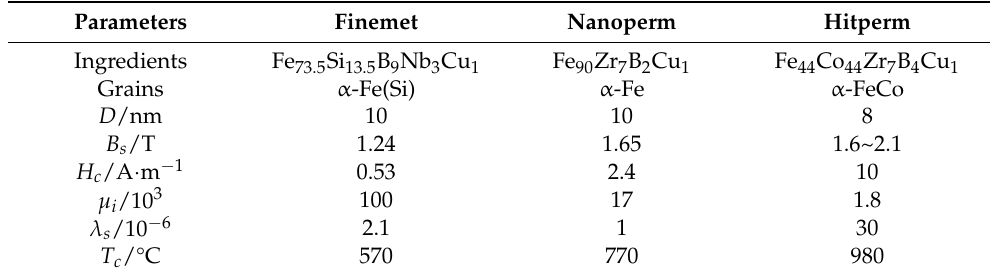
Table 8. Microstructure and magnetic properties of three typical nanocrystalline materials.